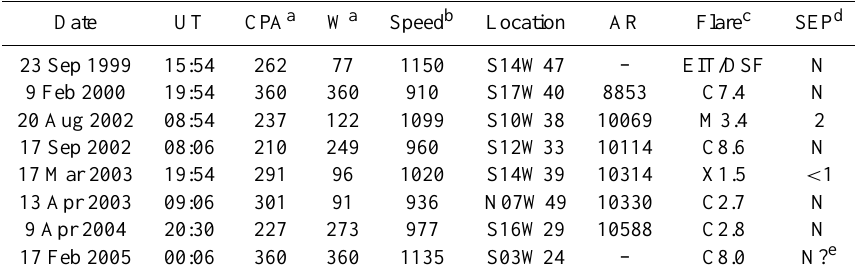
Table 4. List of RQ CMEs with source locations overlapping with RL disk